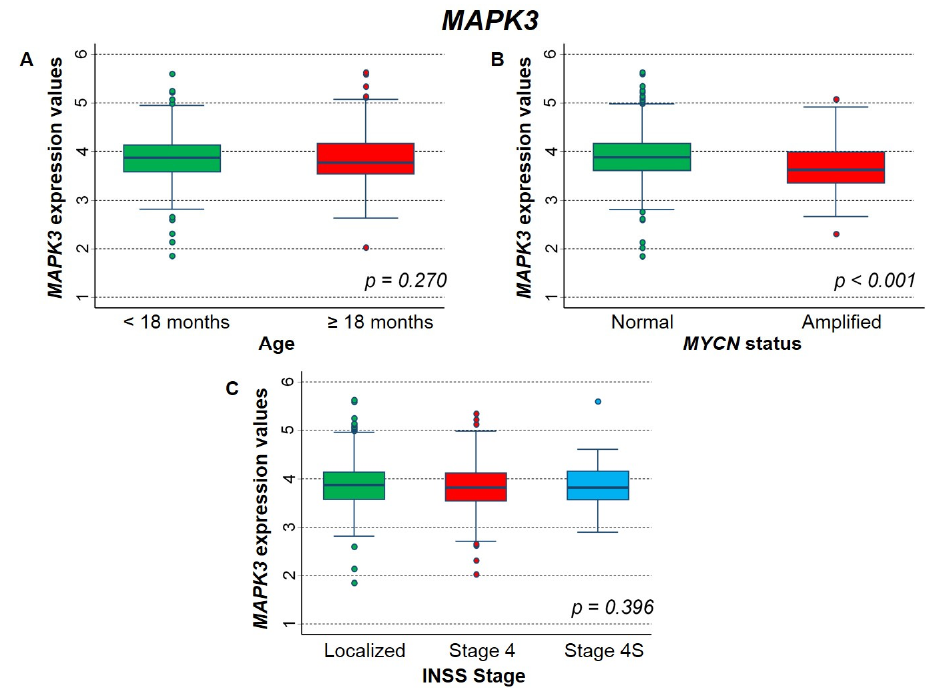
Figure 10. Association between MAPK3 gene expression and the main patient characteristics at diagnosis evaluated on the entire cohort. ( A ) Age; ( B ) MYCN status; ( C ) INSS stage. Kaplan–Meier survival analysis did not highlight any association between MAPK3 gene expression and either OS (Figure 11A,B) or EFS (Figure 11C,D). In multivariable Cox regression analysis, values higher than the median were slightly associated with a poorer OS (HR = 1.4), but without any evidence of trend, while no association emerged for EFS (Table 5). No association was observed between MAPK3 expression levels and either OS or EFS after stratification by MYCN status (Supplementary Table S6). Stratification by stage (Supplementary Table S7) indicates a poorer OS for patients with localized disease and values below the first tertile. Conversely, in Stage 4S patients, a lower survival was asso- ciated to values above the median expression level for both OS and EFS, but without evidence of trend.